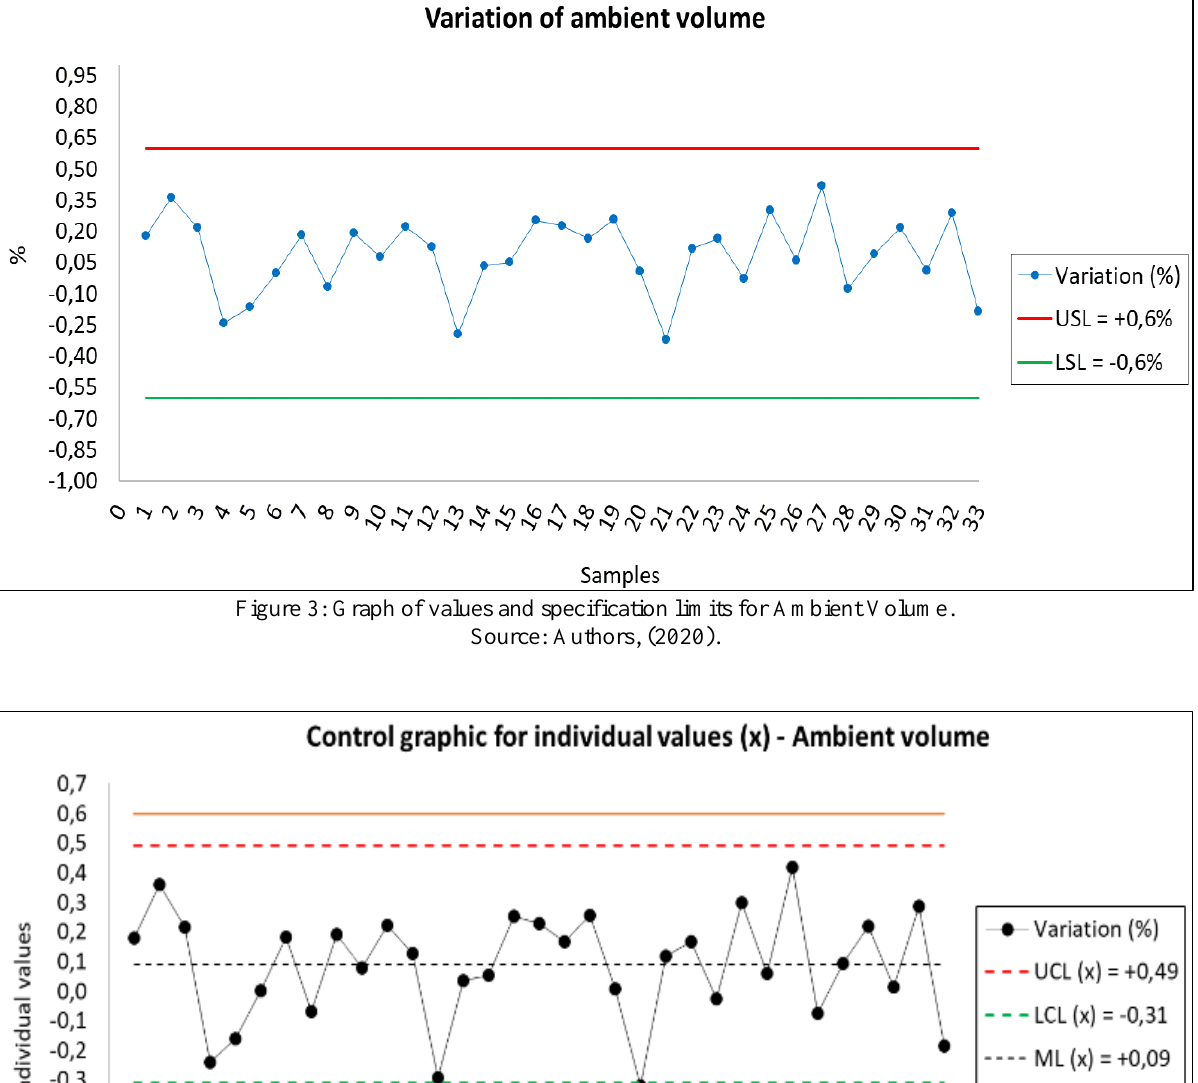
Figure 4: Control chart of individual values ( x ) - Ambient